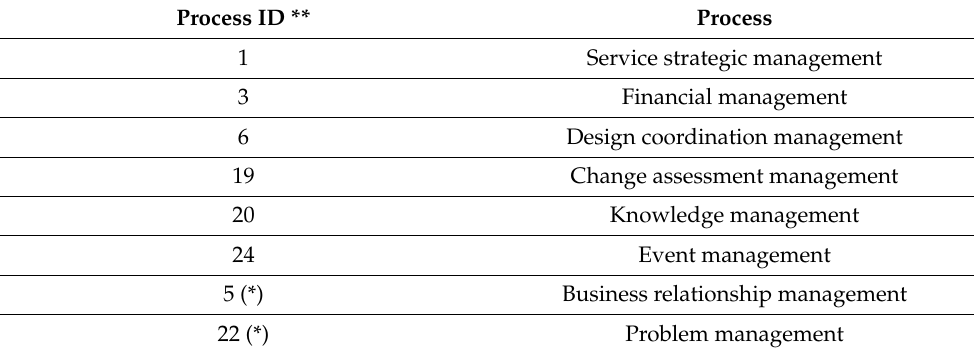
Table 2. Restrictions: list of processes to exclude from the optimization.